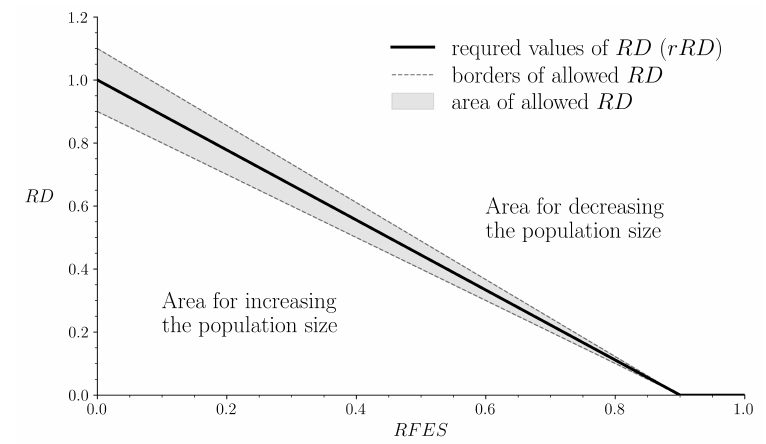
Figure 1. Diversity-based mechanism of population size